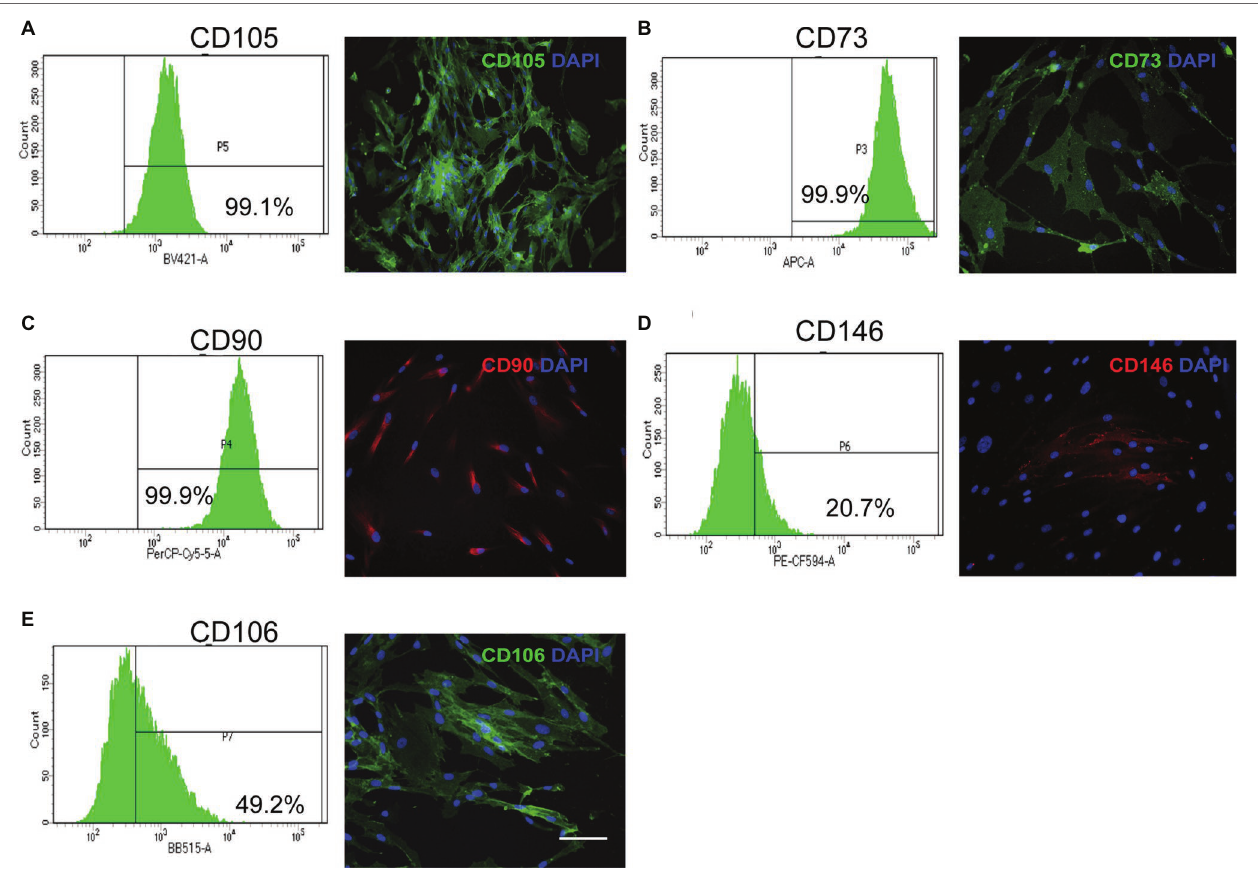
FIGURE 3 | Stem cell mesenchymal markers in primary cultures of human periodontal connective tissue cells. Human periodontal ligament cells were immunostained for selected cell surface markers, counterstained with DAPI, and evaluated through flow cytometry, using an antibody panel. Flow cytometry histograms with percentage of positive cells and representative immunofluorescence images are shown. (A) CD105 (B) CD73 (C) CD90 (D) CD146 (E) CD106. Magnification bar equals 50 μ m. (Images in this figure correspond to reanalysis of previously published data in Martinez et al.,